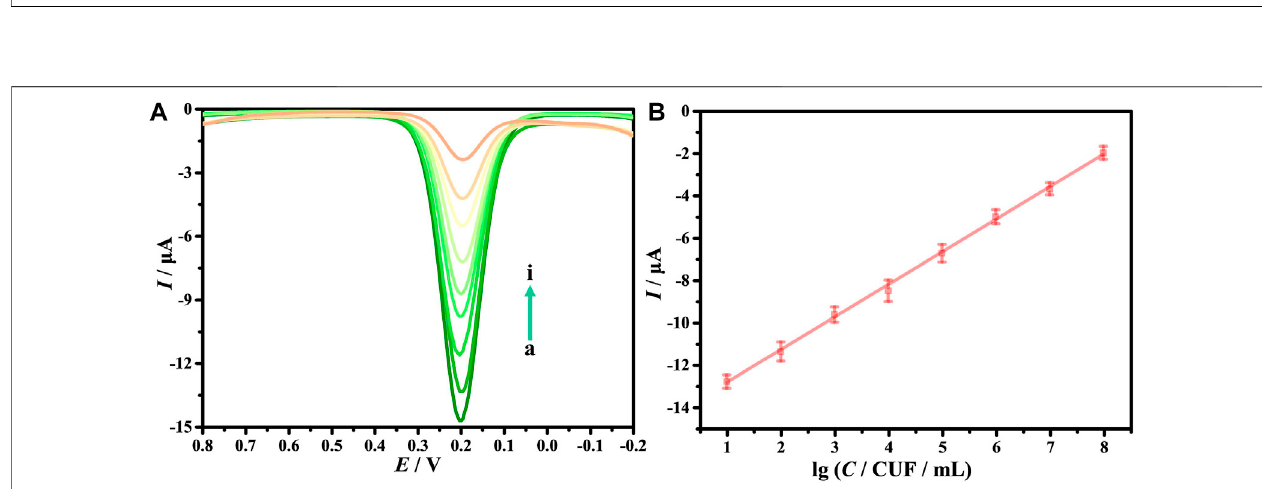
FIGURE 5 | (A) I pa of 10 5 CFU/ml different bacteria on the DNA/CDs-Fe 3 O 4 /GCE, (B) I pa of 10 5 CFU/ml E. coli O157:H7 with different bacteria on the DNA/CDs- Fe 3 O 4 /GCE (a: none, b: E. coli O157:H7, c: S. aureus , d: Salmonella , e: S. lactis , and f: Listeria ).